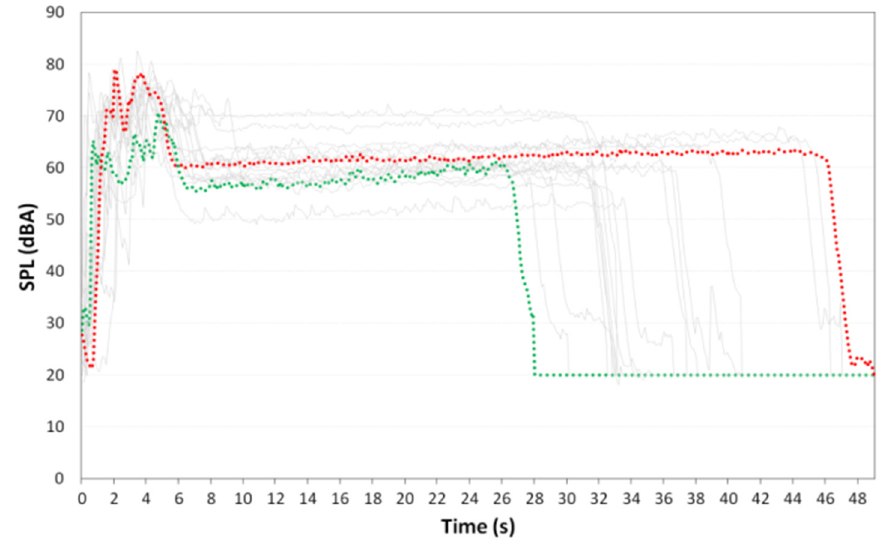
Figure 6. Time history of the noise from the use of the water closet installed in 19 bathrooms of 11 housings with different floor plans (longest time with red dot: bathroom attached to the living room of the 59A type; shortest time with green dot: bathroom attached to the bedroom of the 84A type).